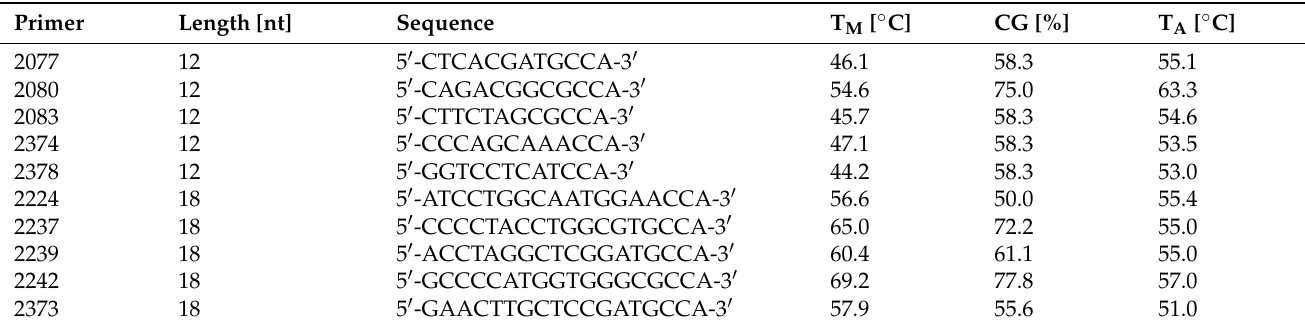
Table 2. Details of the primers used in study.